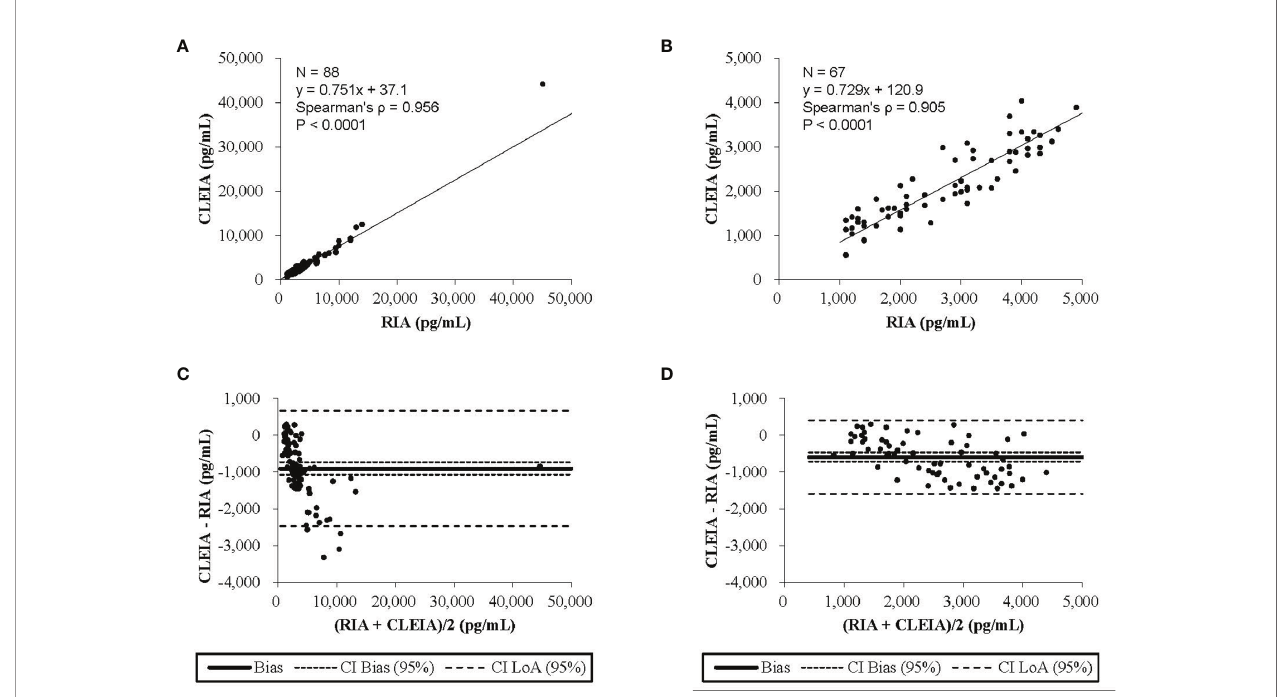
FIGURE 2 | The results of the Passing-Bablok regression analysis and the Blond-Altman analysis. (A) The chemiluminescent enzyme immunoassay (CLEIA) versus the radioimmunoassay (RIA). (B) The CLEIA versus the RIA in a concentration range of up to 500 pg/ml. (C) The CLEIA versus the RIA. (D) The CLEIA versus the RIA in a concentration range of up to 5000